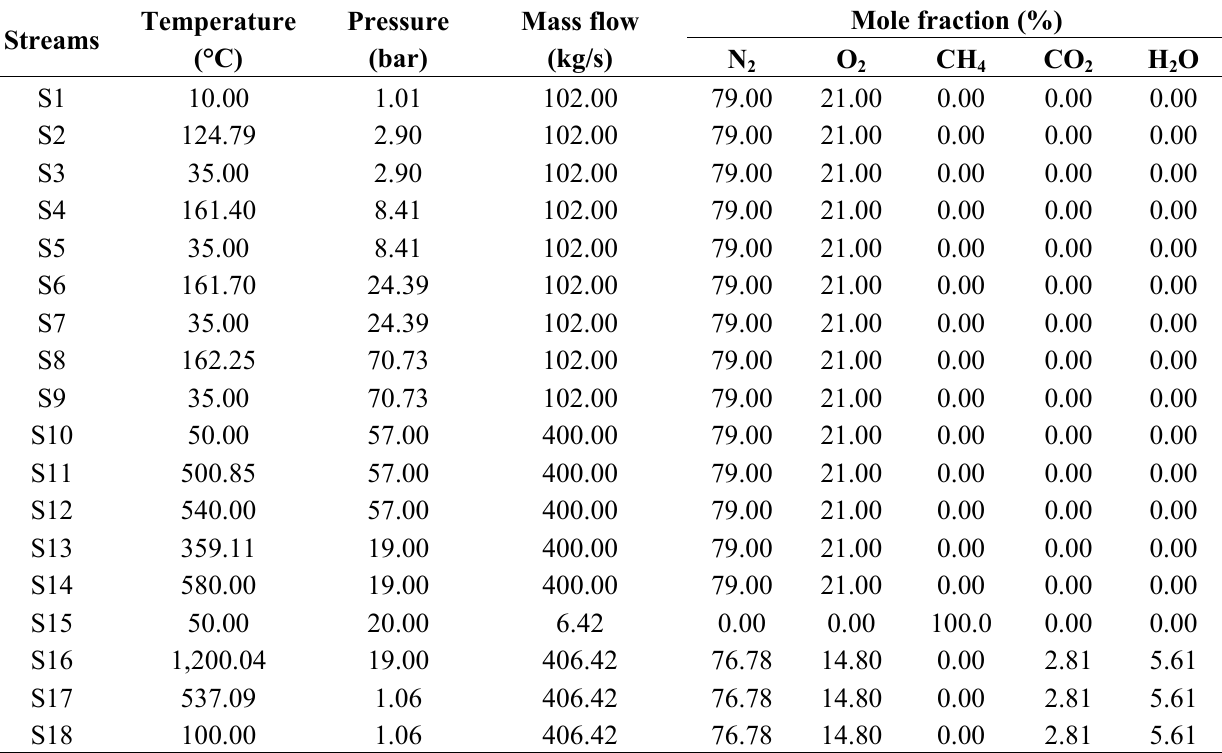
Table 2. Parameters of main points of the hybrid-fuel CAES